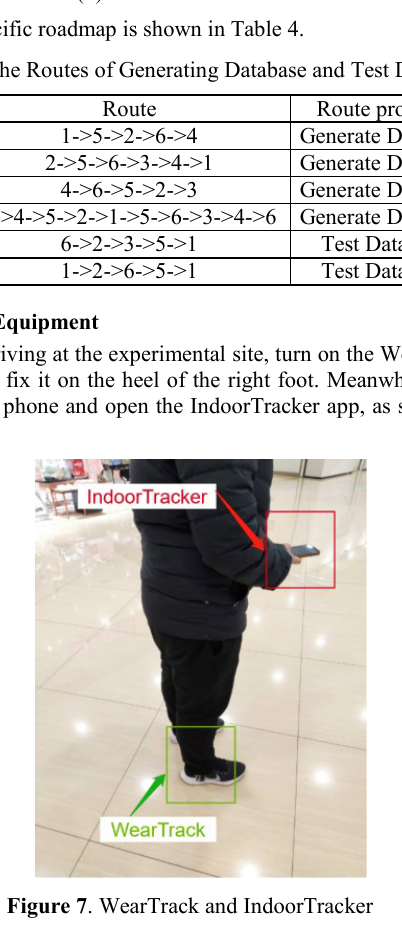
Figure 7 . WearTrack and IndoorTracker